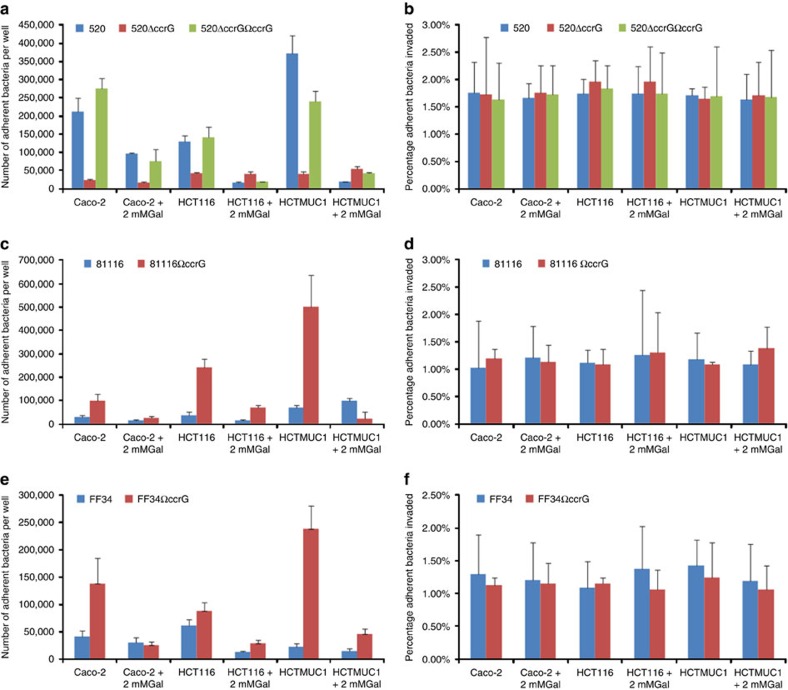
Adhesion and invasion analysis.Adhesion (a, c, e) and invasion (b, d, f) analysis of Caco2, HCT116 and HCT116Ωmuc1 cell lines on C. jejuni 520 wild-type, 520ΔccrG::KmR, 520ΔccrGΩccrG (a and b), 81116 wild-type, 81116ΩccrG (c, d), FF34 wild-type and FF34ΩccrG (e, f) strains. Adhesion and invasion analyses are presented as the mean of invasion from three replicate experiments and standard deviation errors are shown as bars above the mean (P<0.05; t-test).